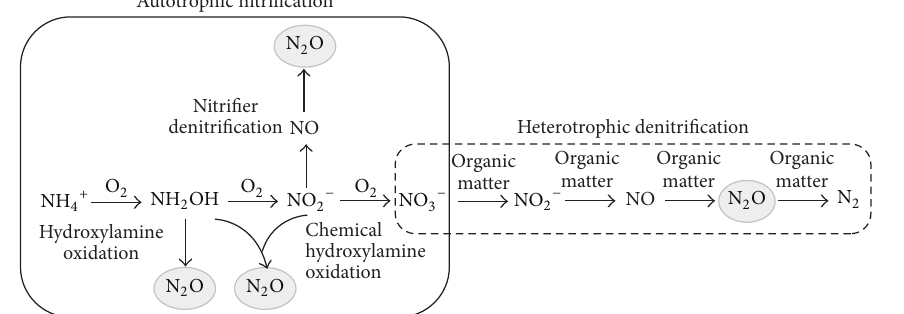
Figure 1: Biological and chemical pathways of N 2 O production in the nitrification and denitrification